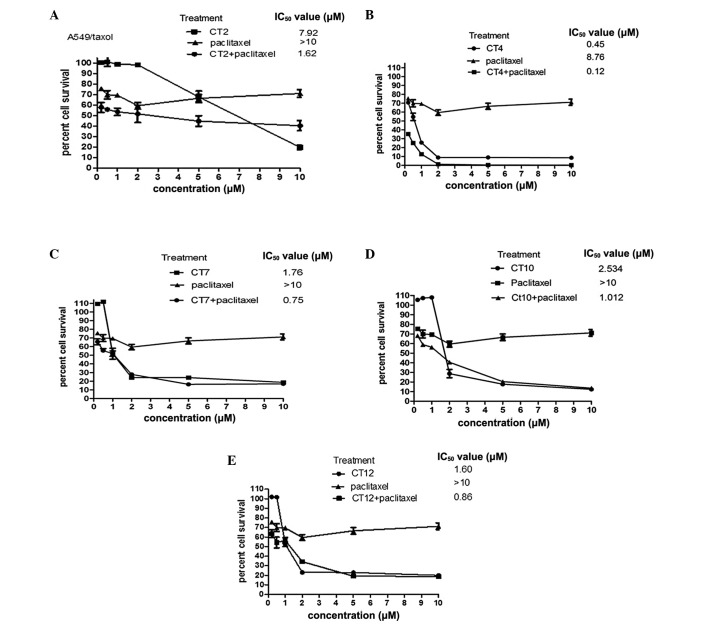
Chemosensitizing effect of cliotides on paclitaxel resistant A549 cells. The data are representative of three independent experiments. All cliotides demonstrated a significant chemosensitizing effect. Analysis of variance for each graph: P<0.05.